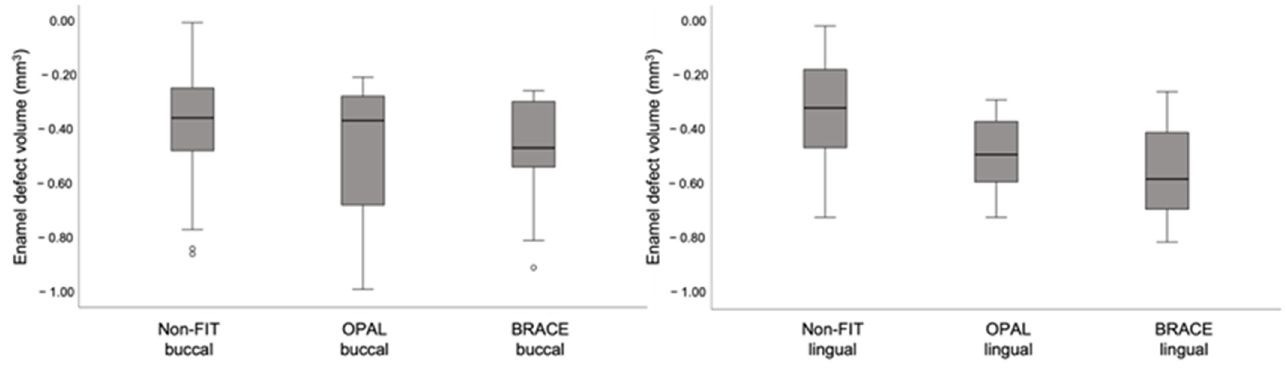
Figure 9. Box-and-whisker plot showing enamel defect depth for buccal ( left ) and lingual ( right ) in the three groups. (Note: °: Mild outliers